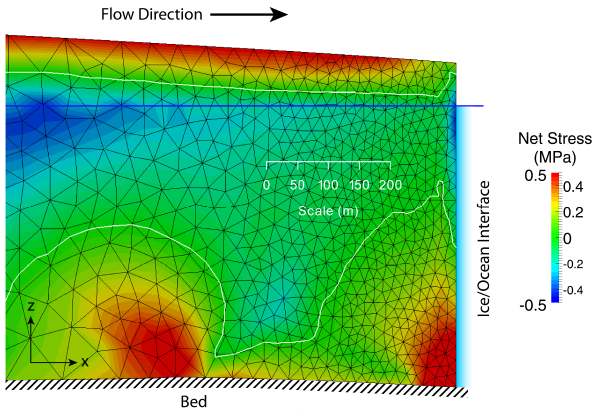
Figure 3. The terminus of the flow line mesh of Store Glacier. White line indicates the net stress ( σ n ) zero contour for both surface and basal crevasses. Net stress (MPa) is > 0 where crevasses exists and < 0 in solid and unfractured ice. Calving occurs in the model when the surface and basal zero contours meet. The blue line indicates sea